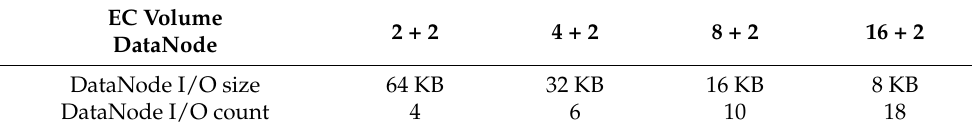
Table 1. The 128 KB I/O process size in the DataNode according to the EC setting.